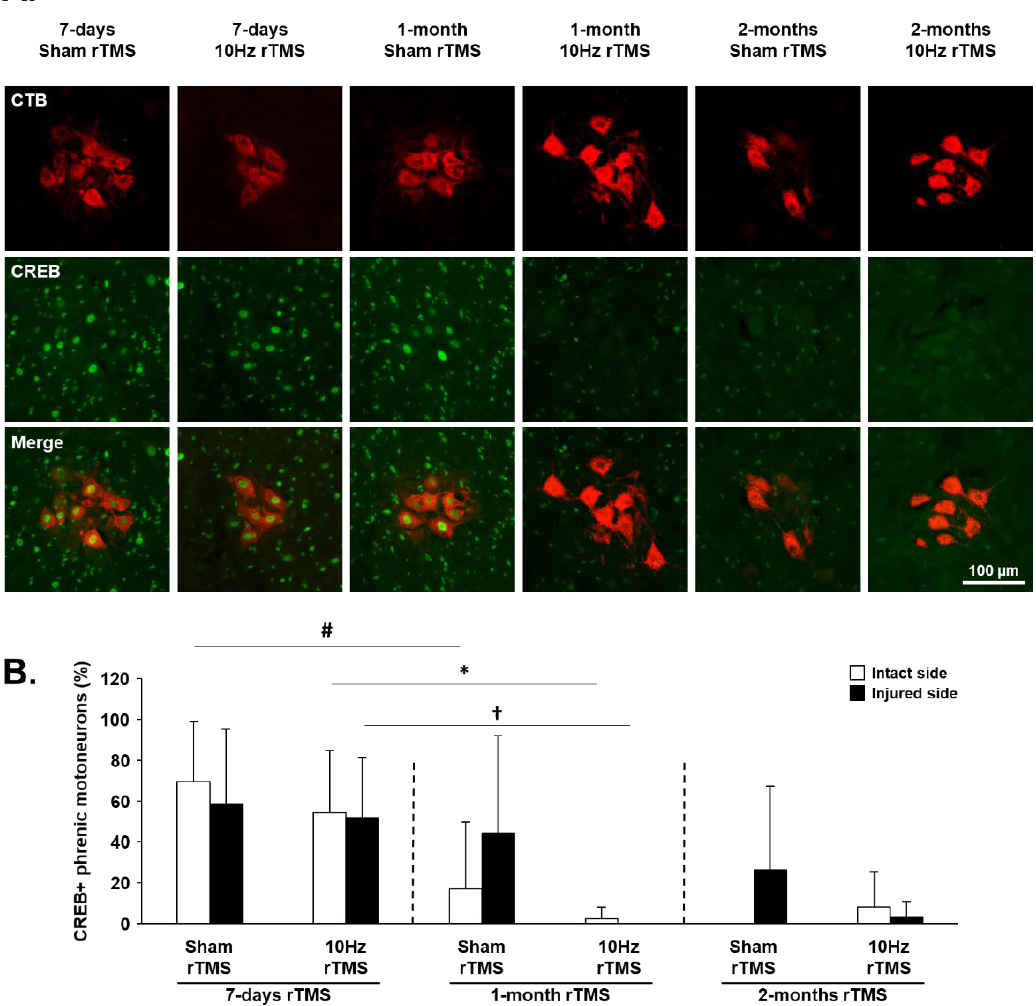
Figure 6. CREB expression in phrenic motoneurons following C2 hemisection: ( A ) representative images showing expression of CREB in denervated phrenic motoneurons labeled with CTB in C2 hemisected rats, following 7 days, 1 month or 2 months of Sham or 10 Hz rTMS treatment; ( B ) quantification of the percentage of CREB expressing phrenic motoneurons for intact and injured sides of Sham- or 10 Hz rTMS-treated C2 hemisected animals following 7 days, 1 month, or 2 months of treatment. There is no difference between the intact and the injured sides for the different groups (paired t -test for intact vs. injured side, p > 0.05); # 7-day Sham rTMS intact side, compared with 1- month Sham rTMS intact side, p = 0.012. * 7-day 10 Hz rTMS intact side, compared with 1-month 10 Hz rTMS intact side, p = 0.007. † 7-day 10 Hz rTMS injured side, compared with 1-month 10 Hz rTMS injured side, p = 0.004.